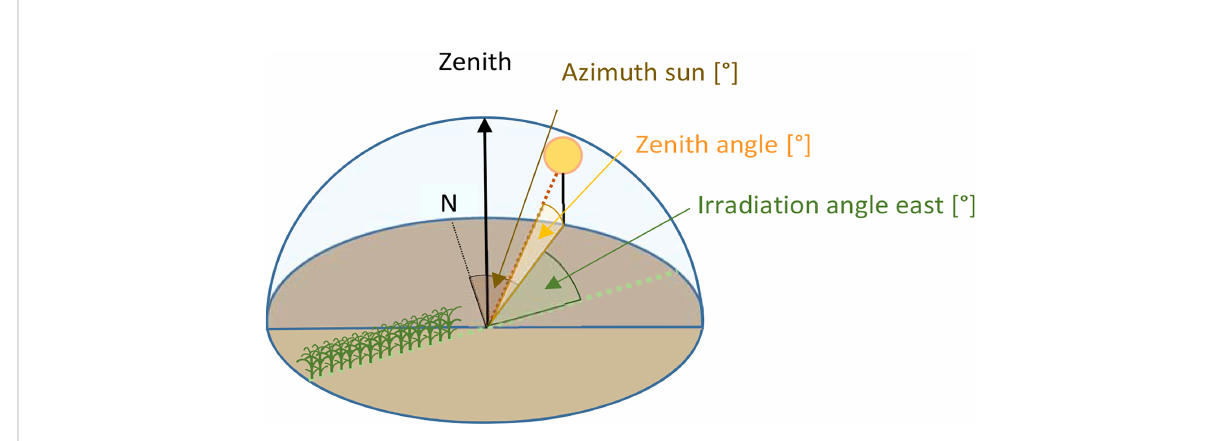
FIGURE 2 Sketch illustrating the geometry of the azimuth, zenith, and irradiation